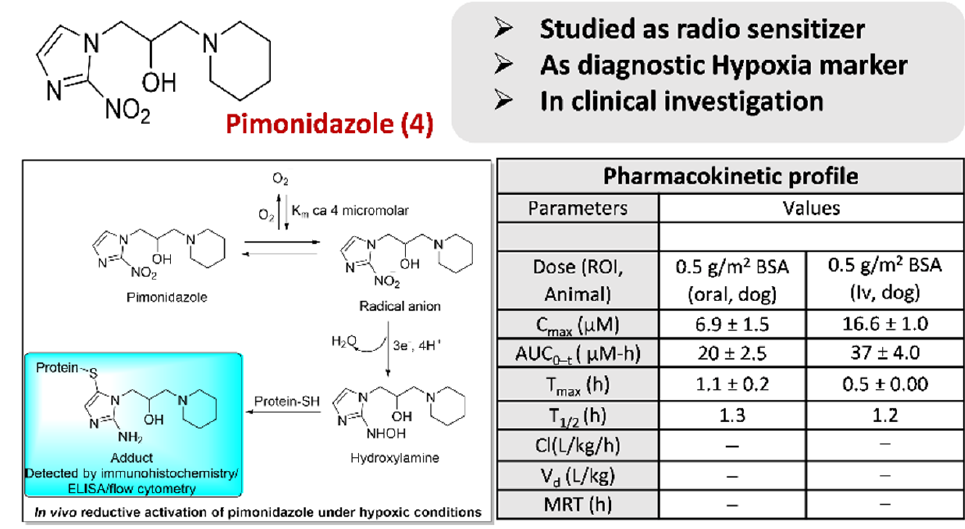
Figure 7. Activity profile of Pimonidazole 4 [34,63].